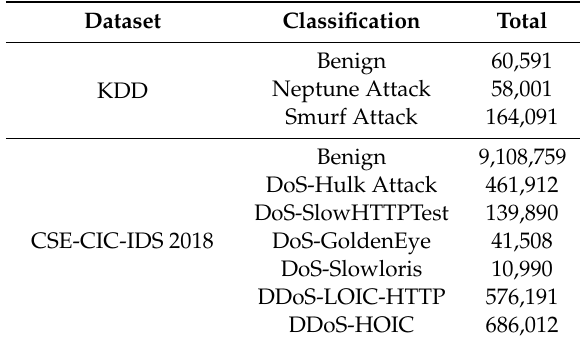
Table 2. Number of DoS samples in KDD and CSE-CIC-IDS